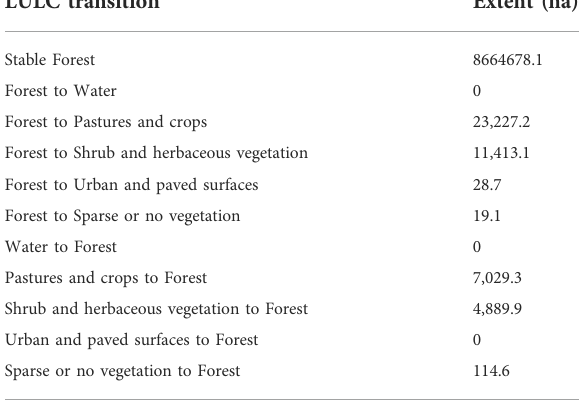
TABLE 4 Land use and land cover (LULC) transitions type and extent (ha) in the central Colombian study area during 2009 – 2012. LULC transition Extent (ha) Stable Forest